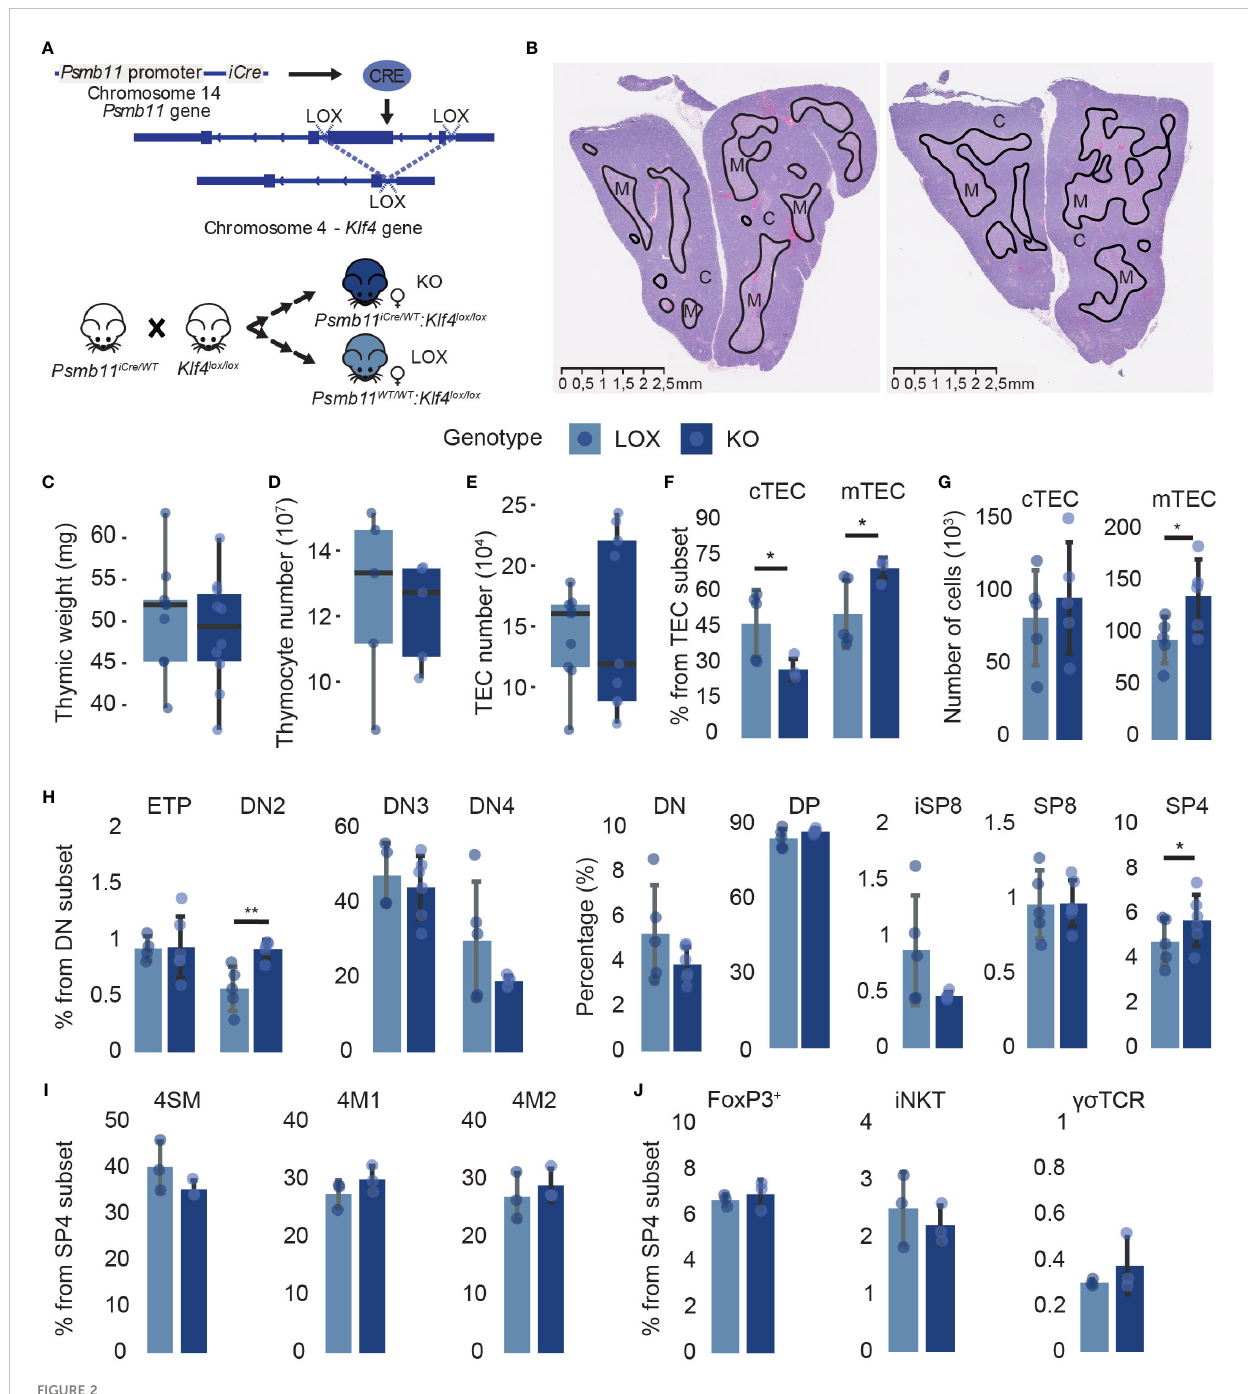
FIGURE 2 Klf4 deletion shows a minor impact on thymic cellularity in homeostatic conditions. (A) Schematic representation of the Cre/loxP system used in the study. (B) H&E staining of thymus from non-pregnant LOX (left) and KO (right) females. Solid black lines delineate cortical (C) and medullary (M) regions. (C – E) Thymic weight (mg) (C) , thymocyte numbers (D) , and TEC numbers (E) in LOX and KO females (from n=5-10 mice per genotype). Results are expressed as the median and interquartile range (IQR). (F, G) cTEC and mTEC proportions (F) and absolute numbers (G) in LOX and KO females (n=4-5). (H) Double-negative thymocyte subpopulations and global thymocyte populations proportions in LOX and KO females (n=4-6). (I, J) Conventional (I) and unconventional (J) SP CD4 thymocyte proportions in LOX and KO females (n=3). CD1d tetramers, as well as Abs against CD25 and TCR gd , were used to exclude NKT cells, regulatory T cells, and gd T cells in the analysis of 4SM, 4M1, and 4M2 subsets. SM, semi-mature; M1, mature 1; M2, mature 2. TEC and thymocytes were analyzed in three and two independent experiments, respectively. LOX and KO genotypes are displayed in pale blue and dark blue, respectively. Signi fi cance was assessed using an unpaired two-tailed Student ’ s t -test. (* p <0.05 and ** p